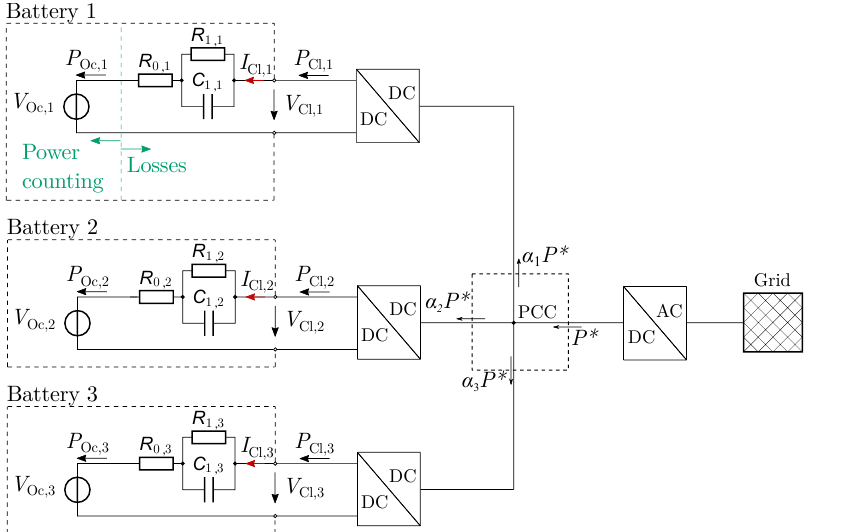
Figure 1. Schematic of the BESS with the differentiation of the clamp and open circuit values of the